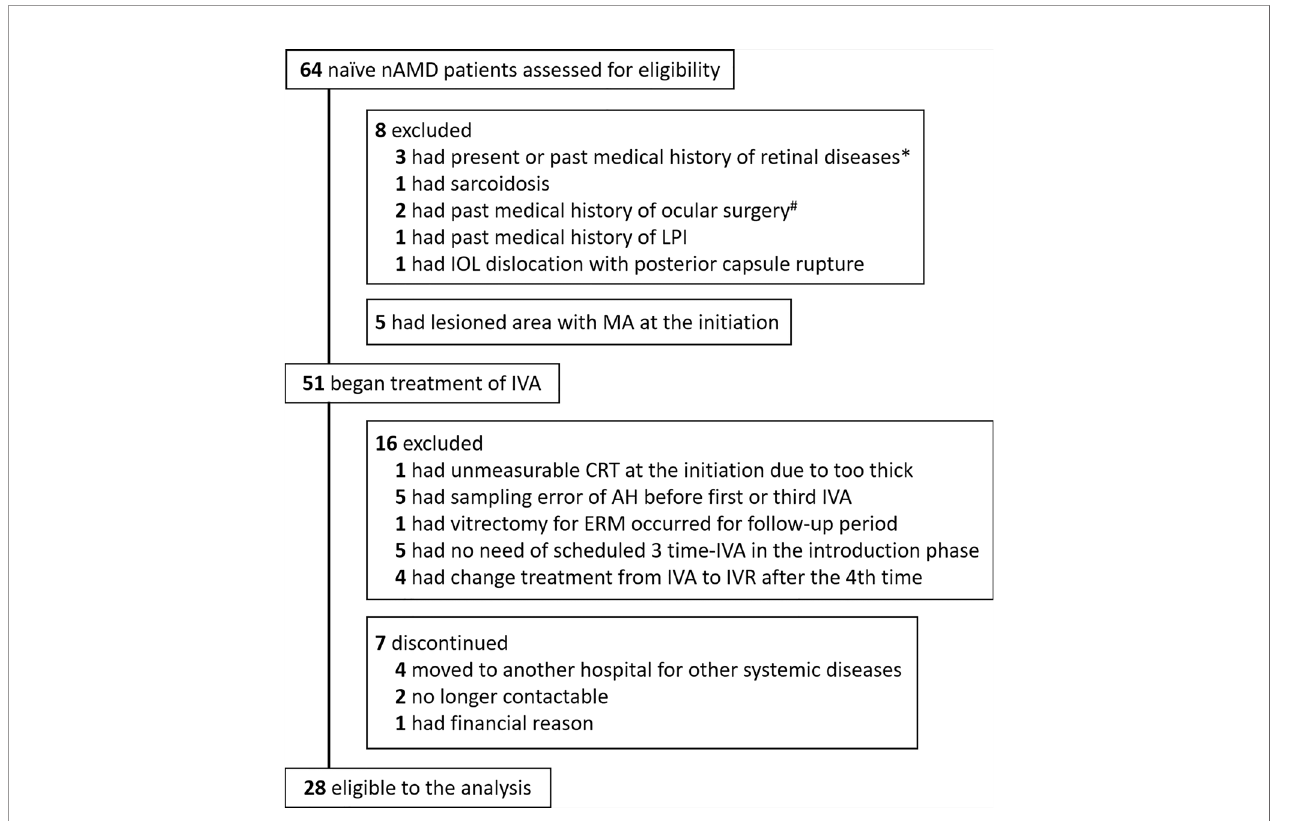
FIGURE 1 | Trial pro fi le. Flowchart of treatment-naive nAMD patients enrolled for IVA treatment is shown. Finally, 28 patients were eligible for analysis in this study. *One patient with branch retinal vein occlusion, one with central serous chorioretinopathy, and one with diabetic macular edema. # One had vitrectomy for epiretinal membrane, and one had scleral buckling for rhegmatogenous retinal detachment. AH, aqueous humor; CRT, central retinal thickness; IOL, intraocular lens; IVA, intravitreal injection of a fl ibercept; LPI, laser peripheral iridotomy; nAMD, neovascular age-related macular